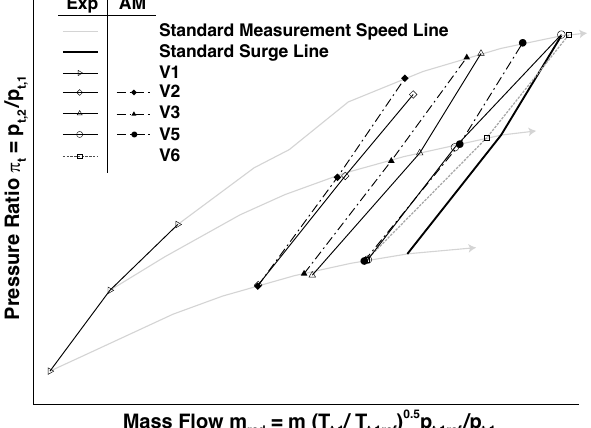
Figure 5. Validation of steady model, Inlet valve fully